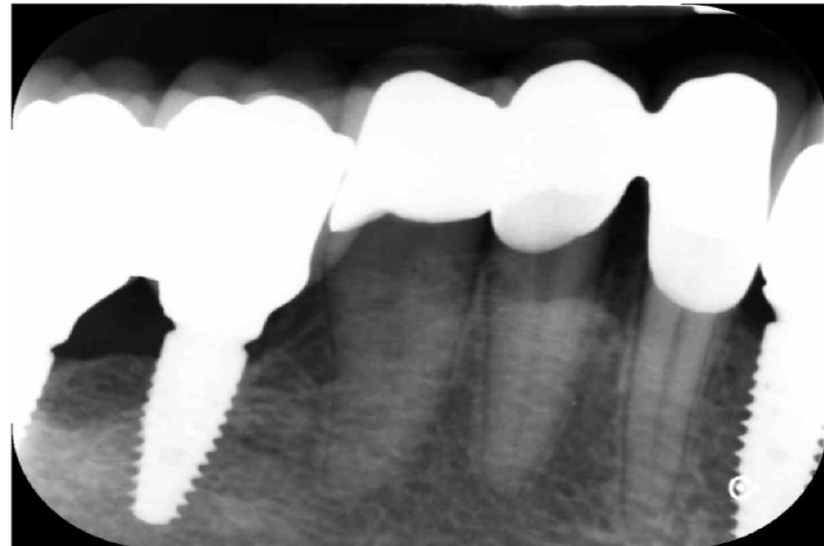
Figure 18. Radiographic control at the time of luting.